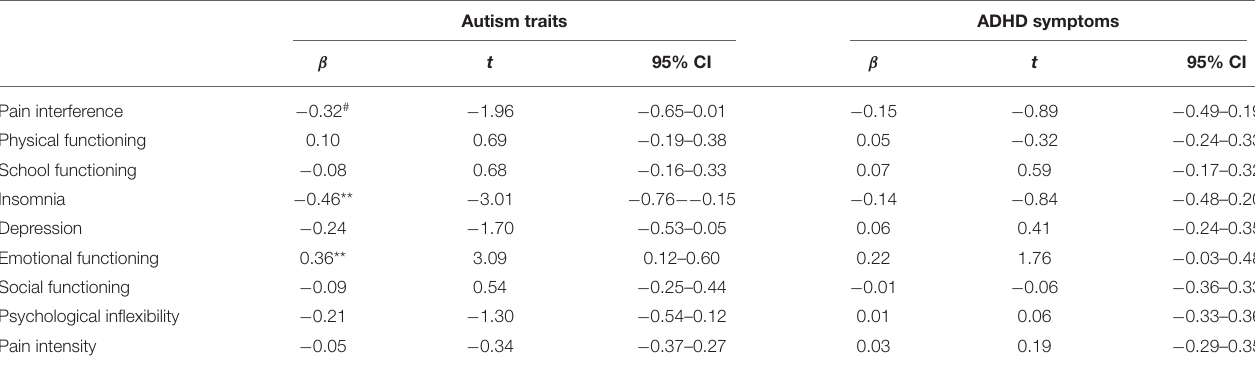
TABLE 3 | Results of the mixed regression analyses of autism traits/ADHD symptoms and change from pre- to post-ACT for all outcomes (autism/ADHD*time); 95% CI = 95% confidence interval; *** p < 0.001, ** p < 0.01, * p < 0.05, # p < 0.07. Autism